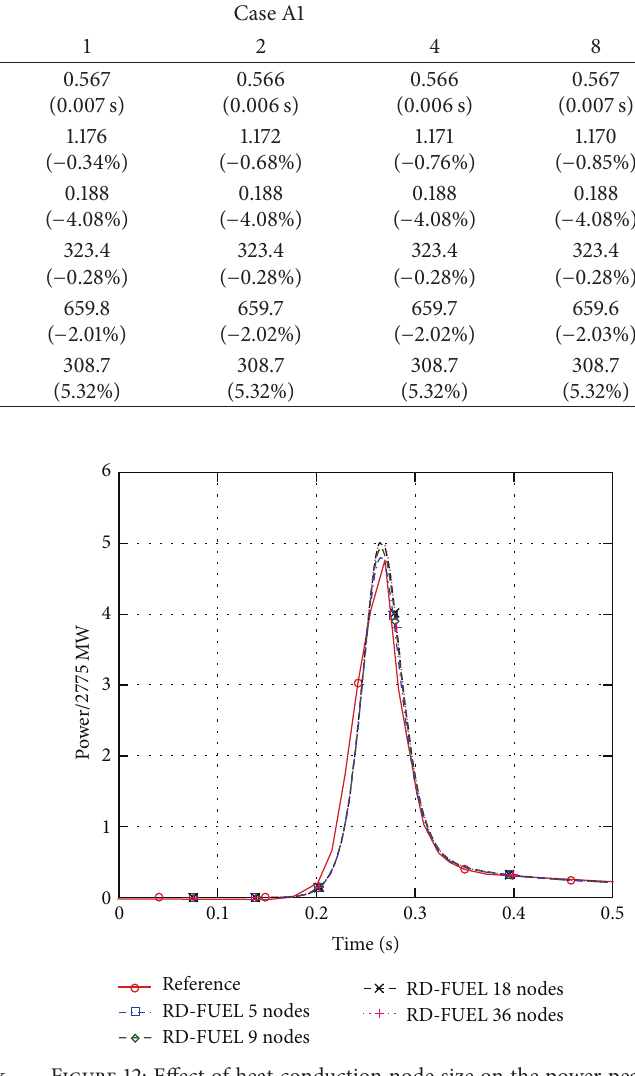
Figure 12: Effect of heat conduction node size on the power peak for case